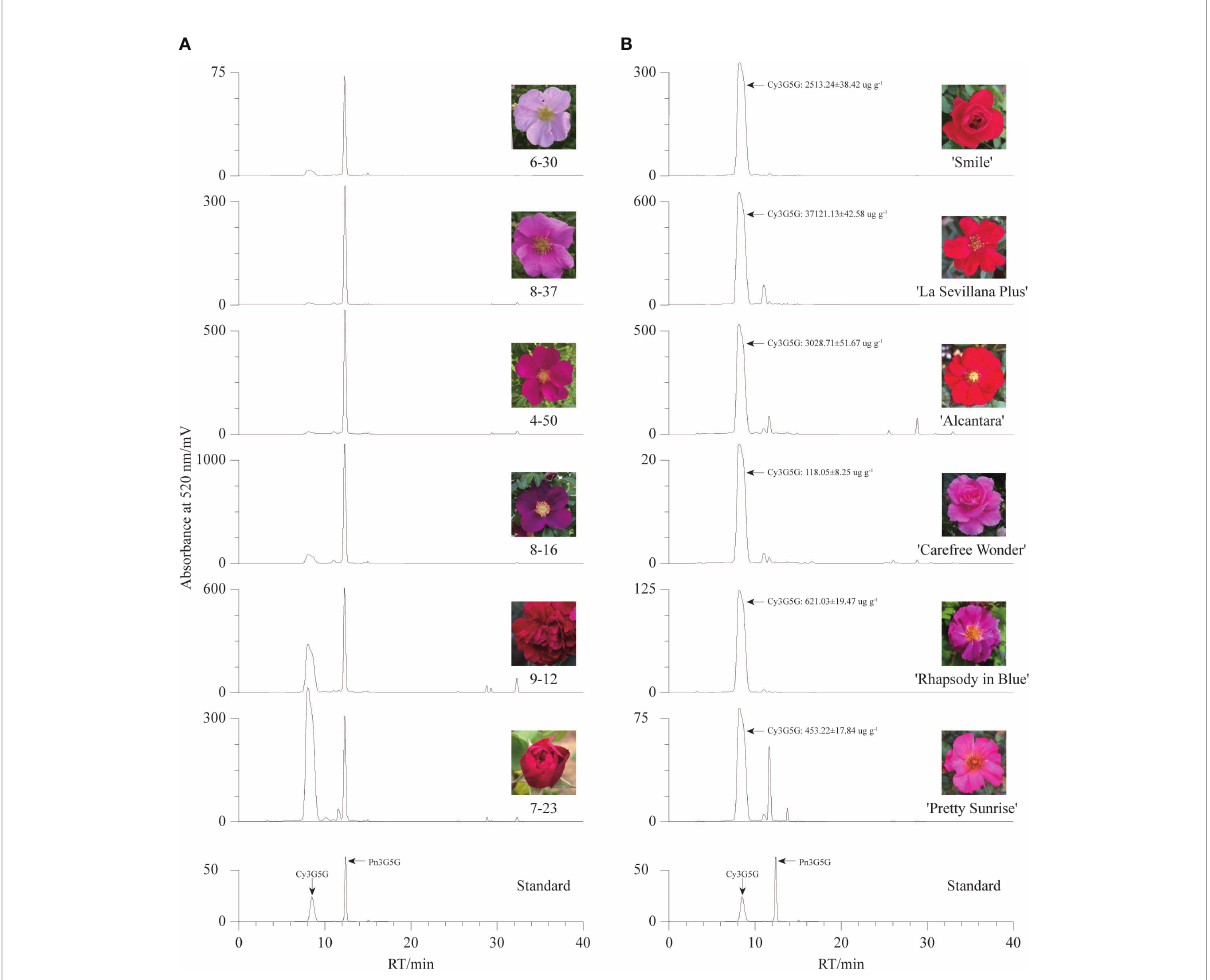
FIGURE 2 Anthocyanin HPLC chromatographic pro fi les of different germplasms. (A) The chromatogram maps of six R. rugosa germplasms. (B) The chromatogram maps of six R. hybrida cultivars.